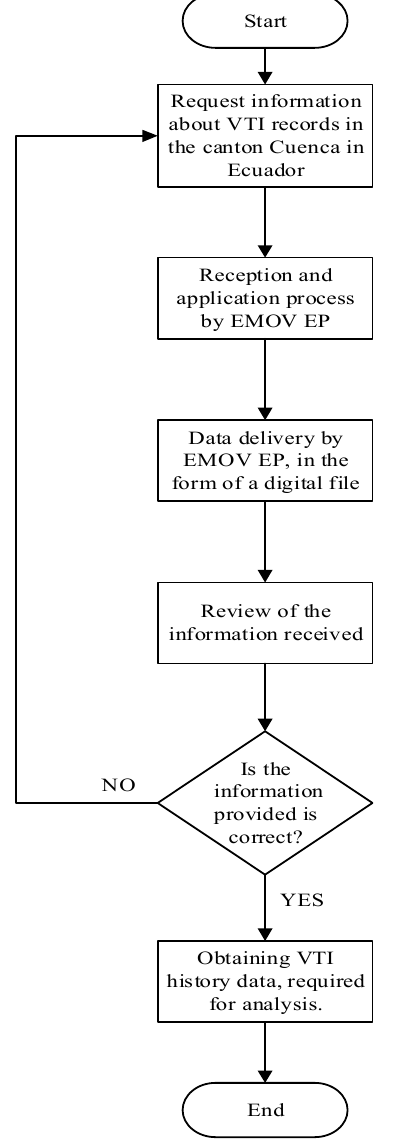
Figure 1. Process for VTI records data collection.